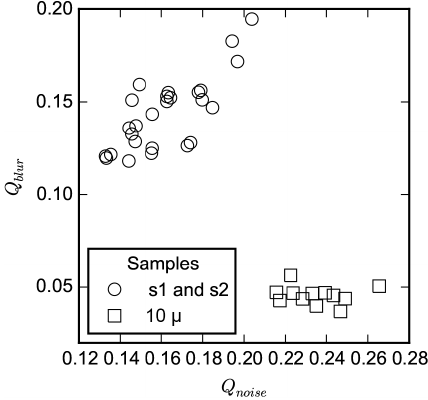
Figure 14. Relative importance of the artefacts due to noise ( Q noise ) and to the fuzzy transition ( Q blur ). Q noise cor- responds to the ratio between the standard deviation of the Gaussian distributions fitted on the attenuation peaks and the difference between the peak attenuation intensity of ice and air (see Sect. 2.2). Q blur corresponds to the area of the Gaussian representing the fuzzy transition in Hagenmuller’s mixture model (see Sect.